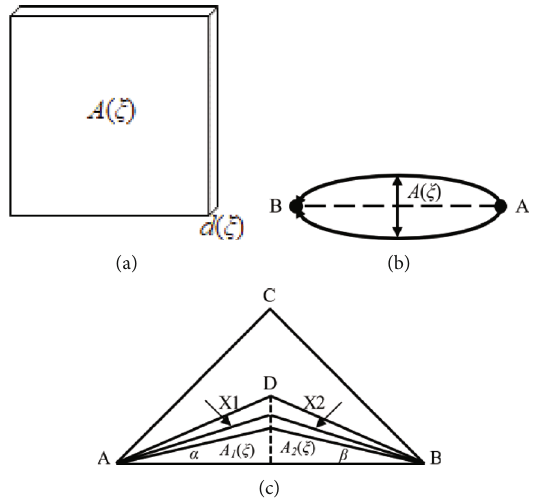
Figure 20: (a) Tiny unit. (b) Flow control area of a single fl ow tube. (c) Drainage area of single